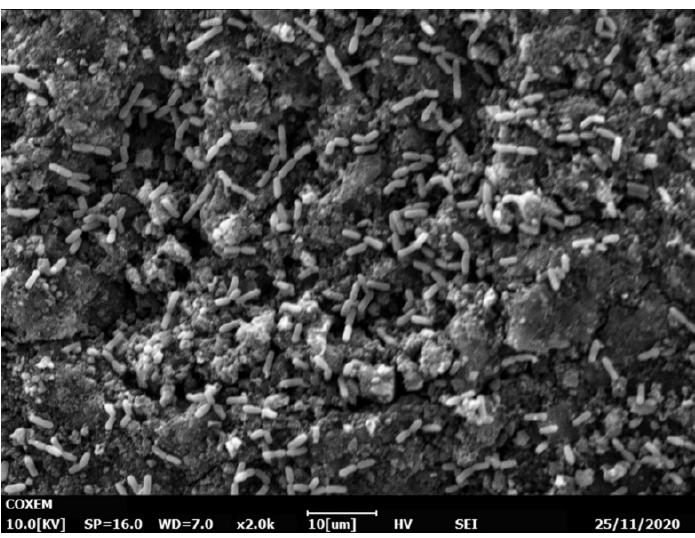
Figure 5. SEM image of the activated carbon surface with attached bacterial cells.